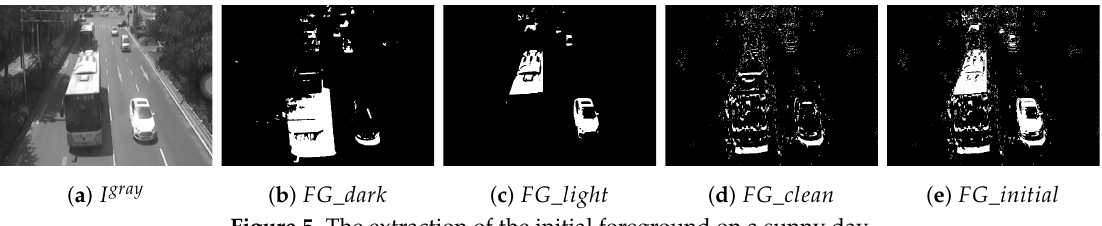
Figure 5. The extraction of the initial foreground on a sunny day.